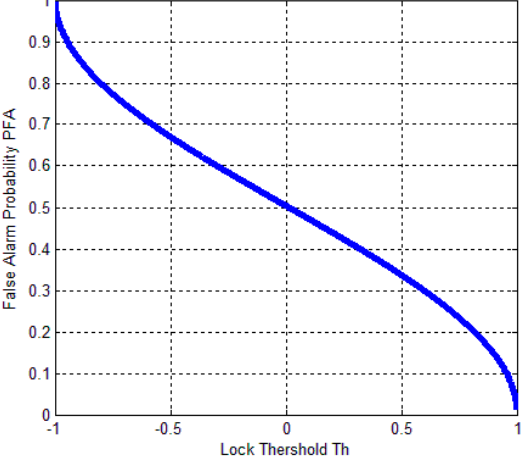
Figure 5. Loop lock probability under different C / N 0 with M = 1.